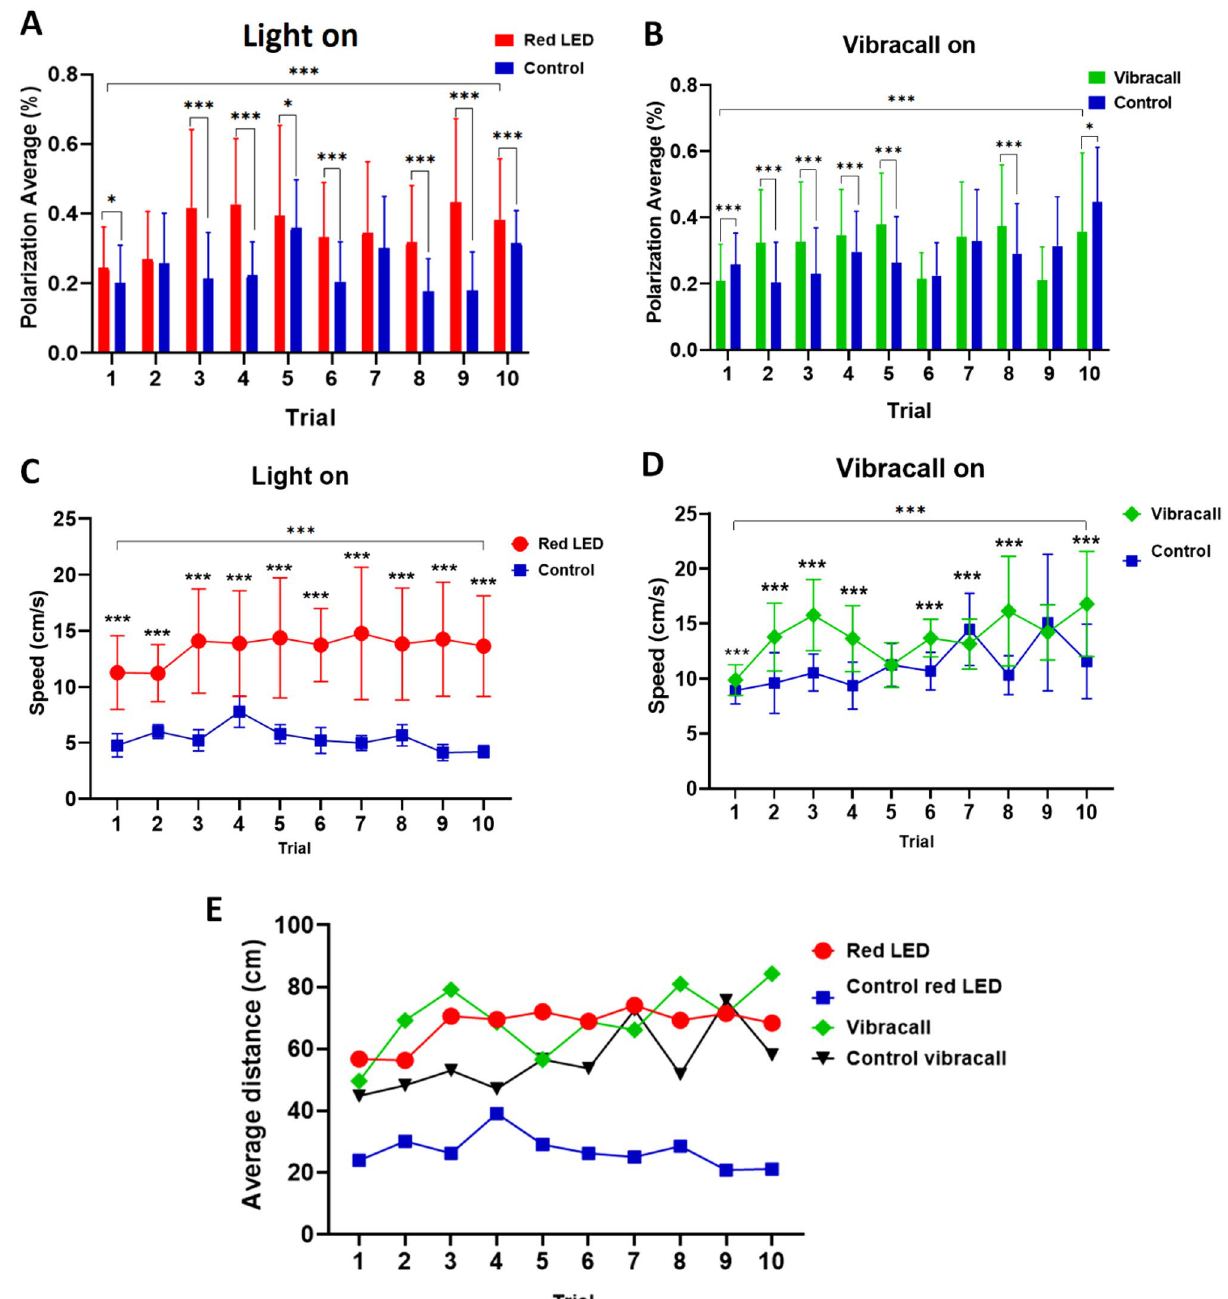
Figure 4. Zebrafish group behavior responses stimulated with red LED light and vibration. ( A ) Average polarization of the zebrafish groups during attempts at conditioning with red light and control group. ( B ) Average polarization of the zebrafish groups during attempts at conditioning with vibracall and control group. ( C ) Average speed covered by the zebrafish groups during conditioning with red light and control group. ( D ) Average speed traveled by the zebrafish groups during conditioning with vibracall and control group. ( E ) Relation of the distance traveled between the groups of fish stimulated with light, vibracall and control. The horizontal lines of each group denote the mean ± SD and the asterisks on the brackets indicate statistical difference in comparison with the frequency of fish between the attempt and the control group by student t test (* p < 0.05; ** p < 0.001, *** p <